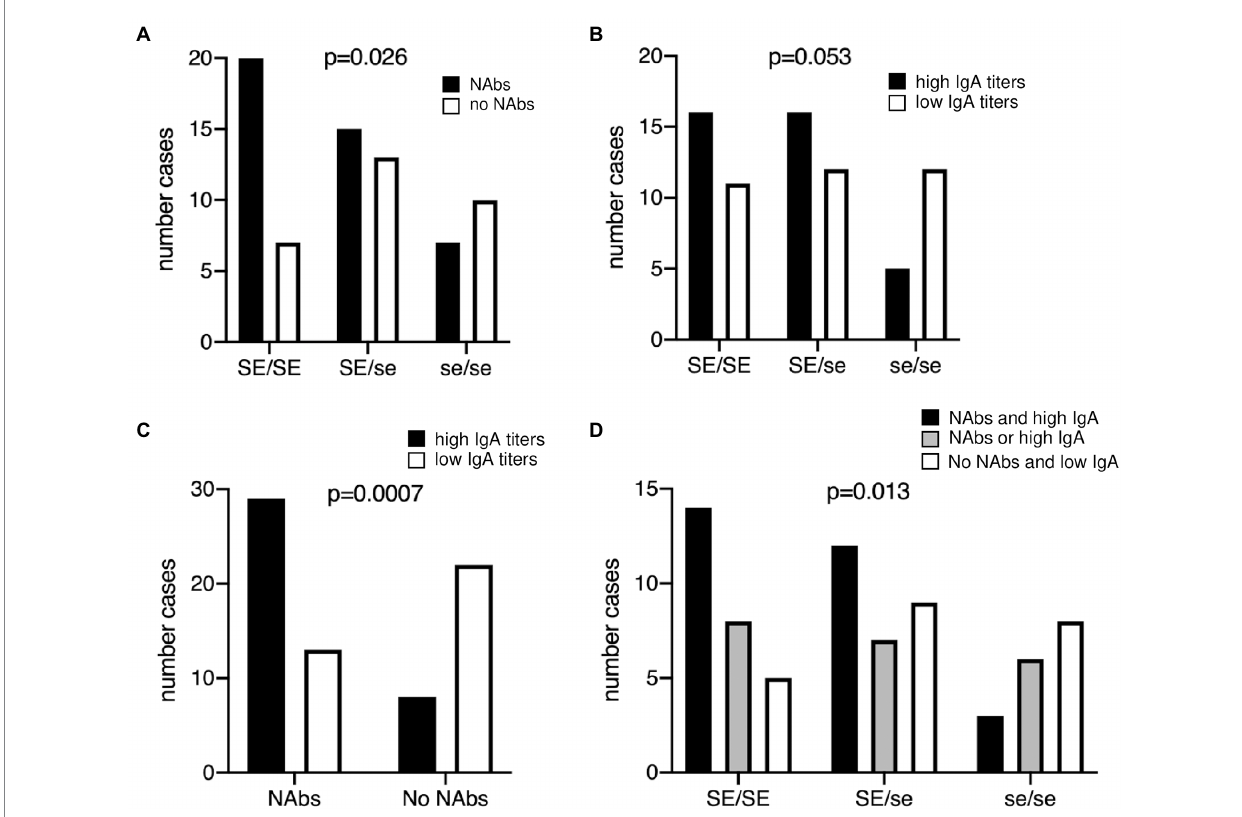
FIGURE 1 Relationship between the presence of anti-RVA antibodies and the FUT2 genotype in healthy young adults. (A) Neutralizing antibodies ( NAbs) titers against the RV strain Wa (G1P[8]) was determined, defining two groups of individuals according to the presence (black bars) or absence (white bars) of neutralizing antibodies, as depicted on Supplementary Figure S1. Chi-square test for trend was used to compare distributions according to the number of wild-type alleles ( p = 0.026). (B) Serum anti-Wa IgA titers were classified as high (black bars) or low (white bars) as shown in Supplementary Figure S1 lower panel. Chi-square test for trend was used to compare distributions ( p = 0.053). (C) Relationship between neutralizing antibodies and IgA titers against the Wa strain. Bars represent individuals with high (black) and low (white) IgA titers, respectively. Fisher’s exact test, p = 0.0007. (D) Individuals anti-RVA status was defined as strong in the presence of both NAbs and high IgA titers (black bars); intermediate either in absence of NAbs but high IgA or in presence of NAbs but low IgA (gray bars); weak in absence of NAbs and with low IgA titers (white bars). Chi-square test for trend was used to compare distributions ( p = 0.013). SE/SE = FUT2 homozygote wild-type; SE/se = FUT2 heterozygotes; se/se = FUT2 null